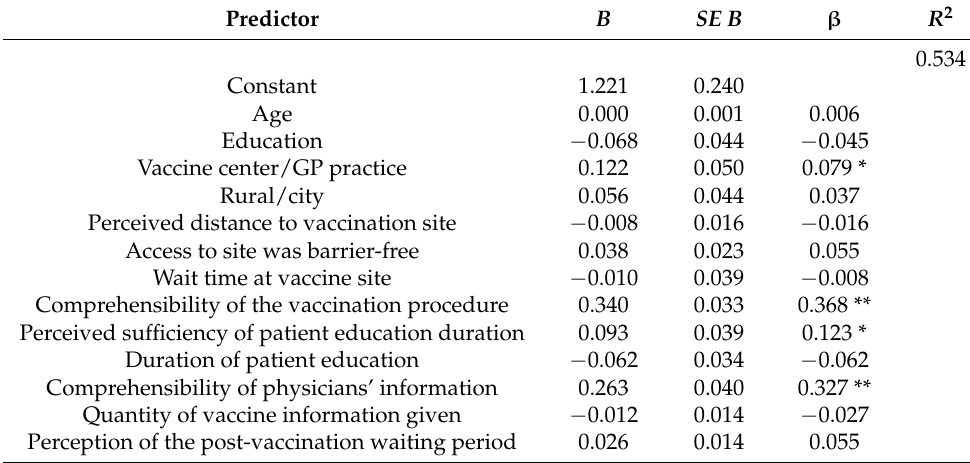
Table 5. Multiple regression analysis predicting recommendation of vaccination at patients’ vaccina- tion site. Predictor B SE